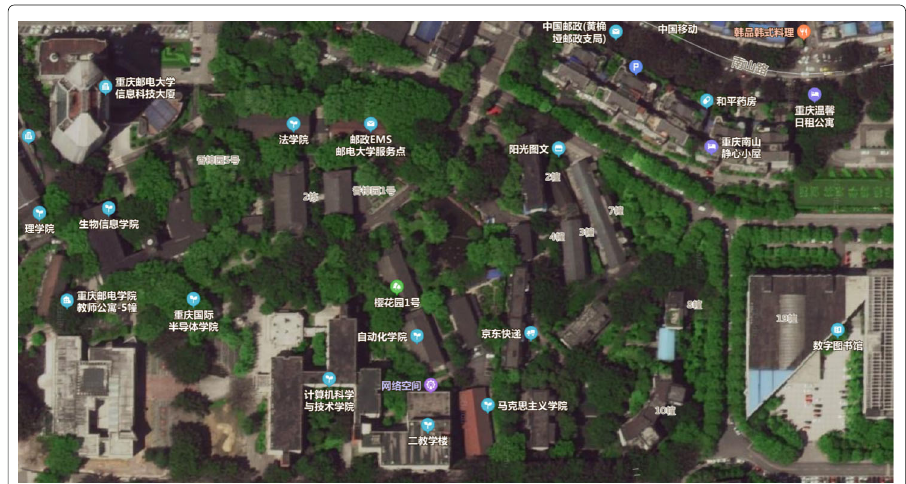
Fig. 14 Satellite scan image of simulation scene